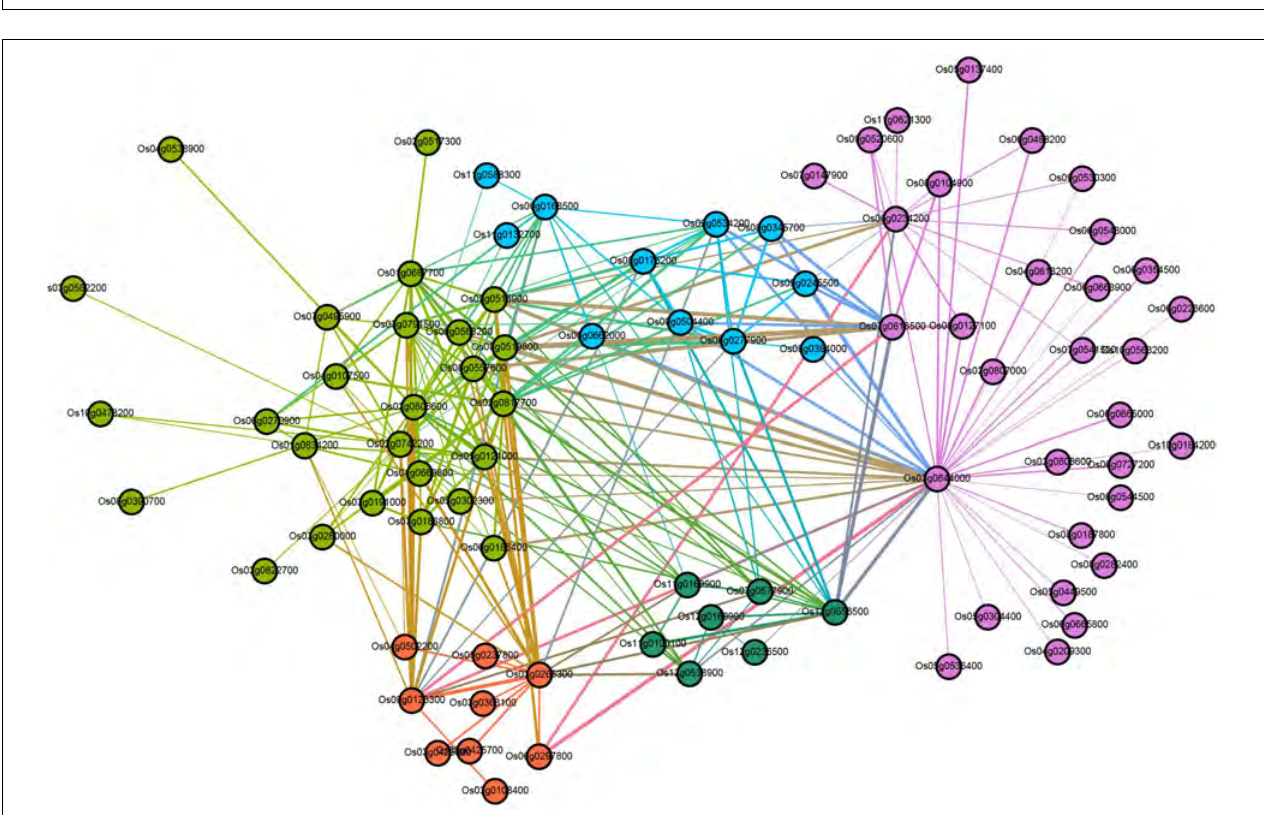
FIGURE 5 | WGCNA of genes identified in ZJ22 and zj-es . (A) Eight modules of co-expressed genes are shown in a hierarchical cluster tree. (B) The expression profile of all the co-expressed genes in the turquoise module. The upper panel is the heat map of gene expression levels in different samples (red, upregulation; green, downregulation); the lower panel is the consensus expression pattern of the corresponding co-expressed genes in this module.